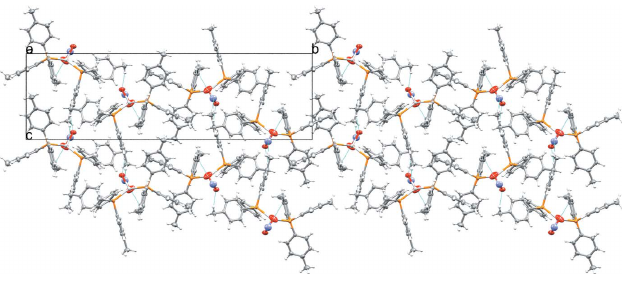
Figure 2 Packing diagram viewed along the a axis indicating two non-classical C—